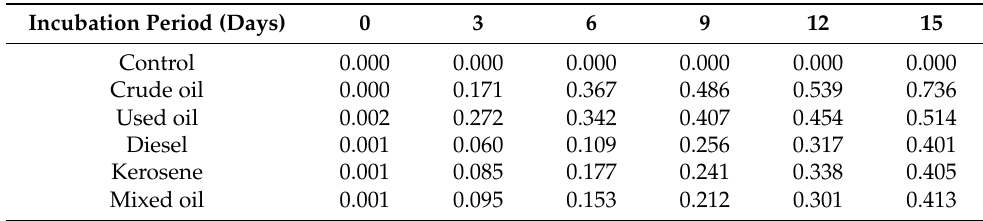
Table 2. The DCPIP colorimetric analysis, expressed in a.u. at 450 nm, of D. spicifera treated with different